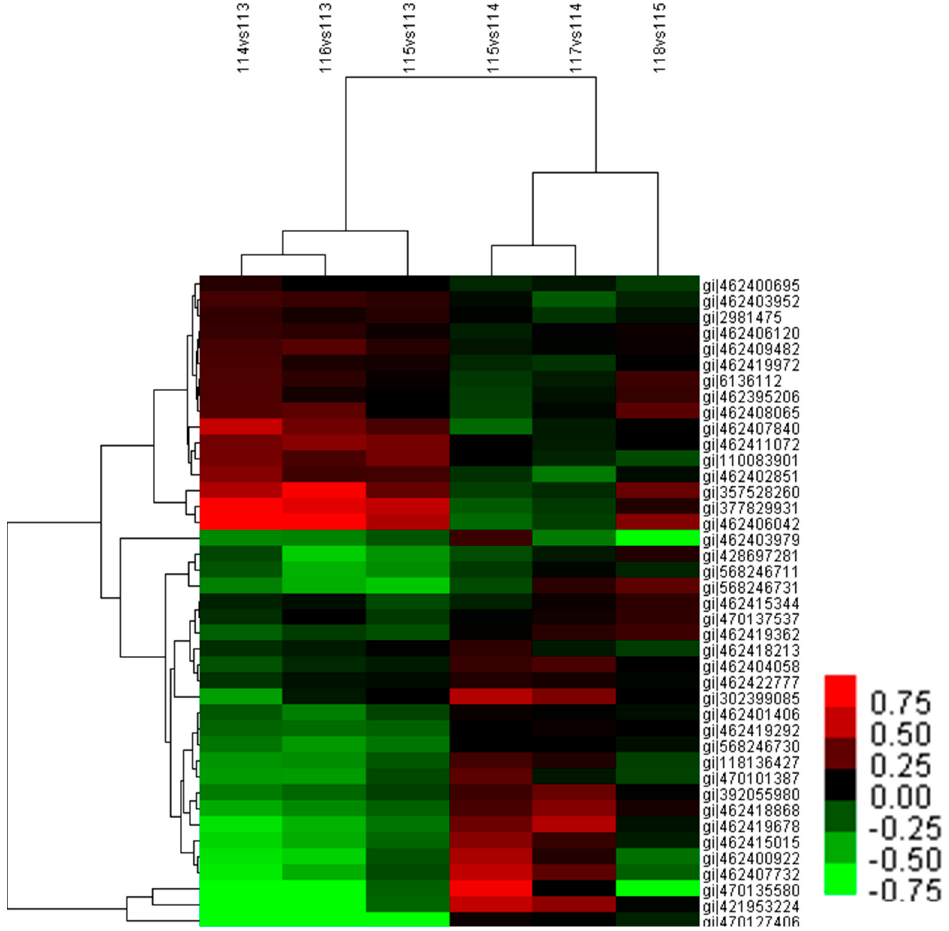
Figure 7. Hierarchical clustering analysis of differentially abundant proteins from M. baccata leaves under different treatments. The rows represent individual proteins. The proteins that increased and decreased in abundance are indicated in red and green, respectively. The proteins that were not changed are indicated in black. The intensity of the colors increased as the difference in abundance increased. 114 vs. 113: 5–20 °C; 116 vs. 113: 5 °C + Ca–5 °C; 115 vs. 113: 0–5 °C; 115 vs. 114: 20–0 °C; 117 vs. 114: 20 °C + Ca–20 °C; 118 vs. 115: 0 °C + Ca–0 °C.